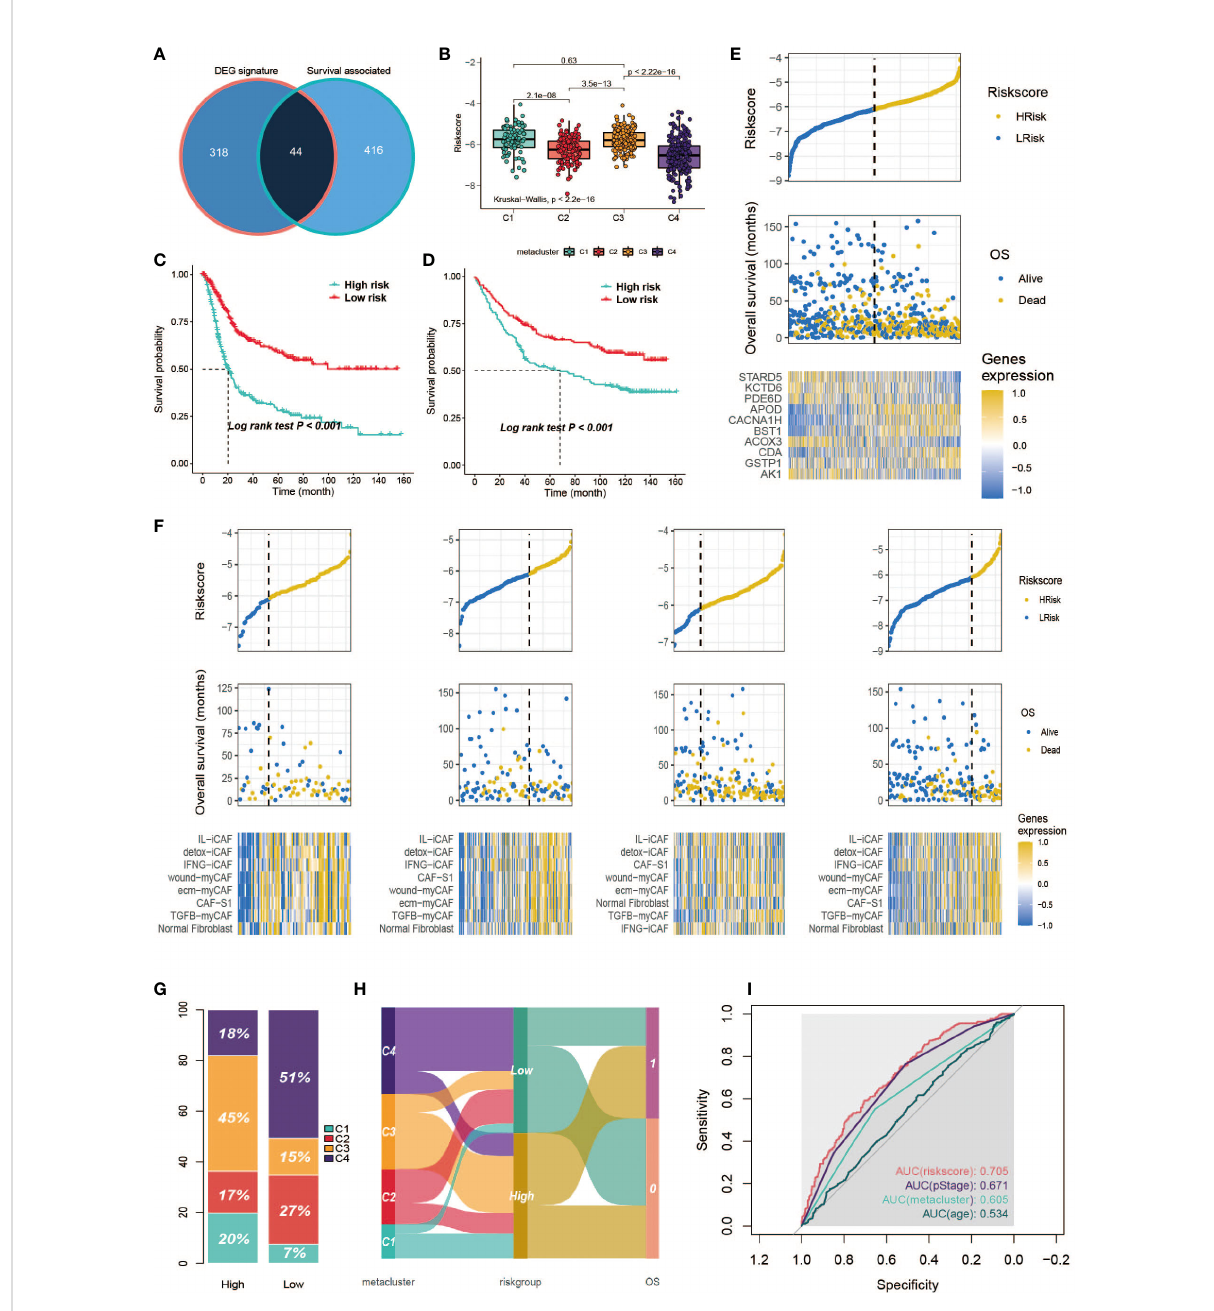
FIGURE 10 Development of a metabolism-related prognostic signature. (A) Venn diagram of DEGs and prognostic-relevant metabolism-associated genes. (B) Correlation between risk score and subclasses. (C, D) Kaplan-Meier plot of the patients in training set and GSE84433 data set. (E) Correlation between signature risk score and patients ’ survival and risk signatures ’ expression. Upper panel shows the distribution of the risk score; middle panel shows the patients ’ survival status and time; bottom shows the heatmap of the risk signatures ’ expression pro fi les. The black dotted line represents the median risk score cutoff dividing patients into low-risk and high-risk groups. (F) Correlation between signature risk score and patients ’ survival and risk signatures ’ expression in each subclass. Bottom panel heatmap of the fi broblasts ’ expression pro fi les. (G) Distribution of the subclasses in high/low risk score groups. (H) ROC analysis of the risk score, pStage, age and metacluster. (I) Sankey plot of the relationship between subclasses and the risk group, and the relationship between risk group and